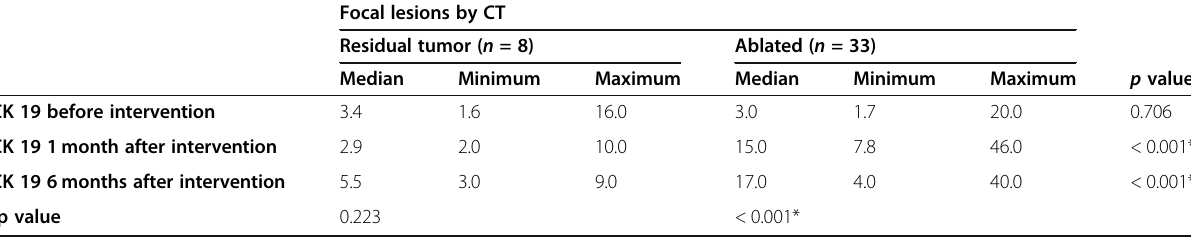
Table 3 Relationship between CK 19 levels and the status of the focal lesions according to the final outcome after 6 months Focal lesions by